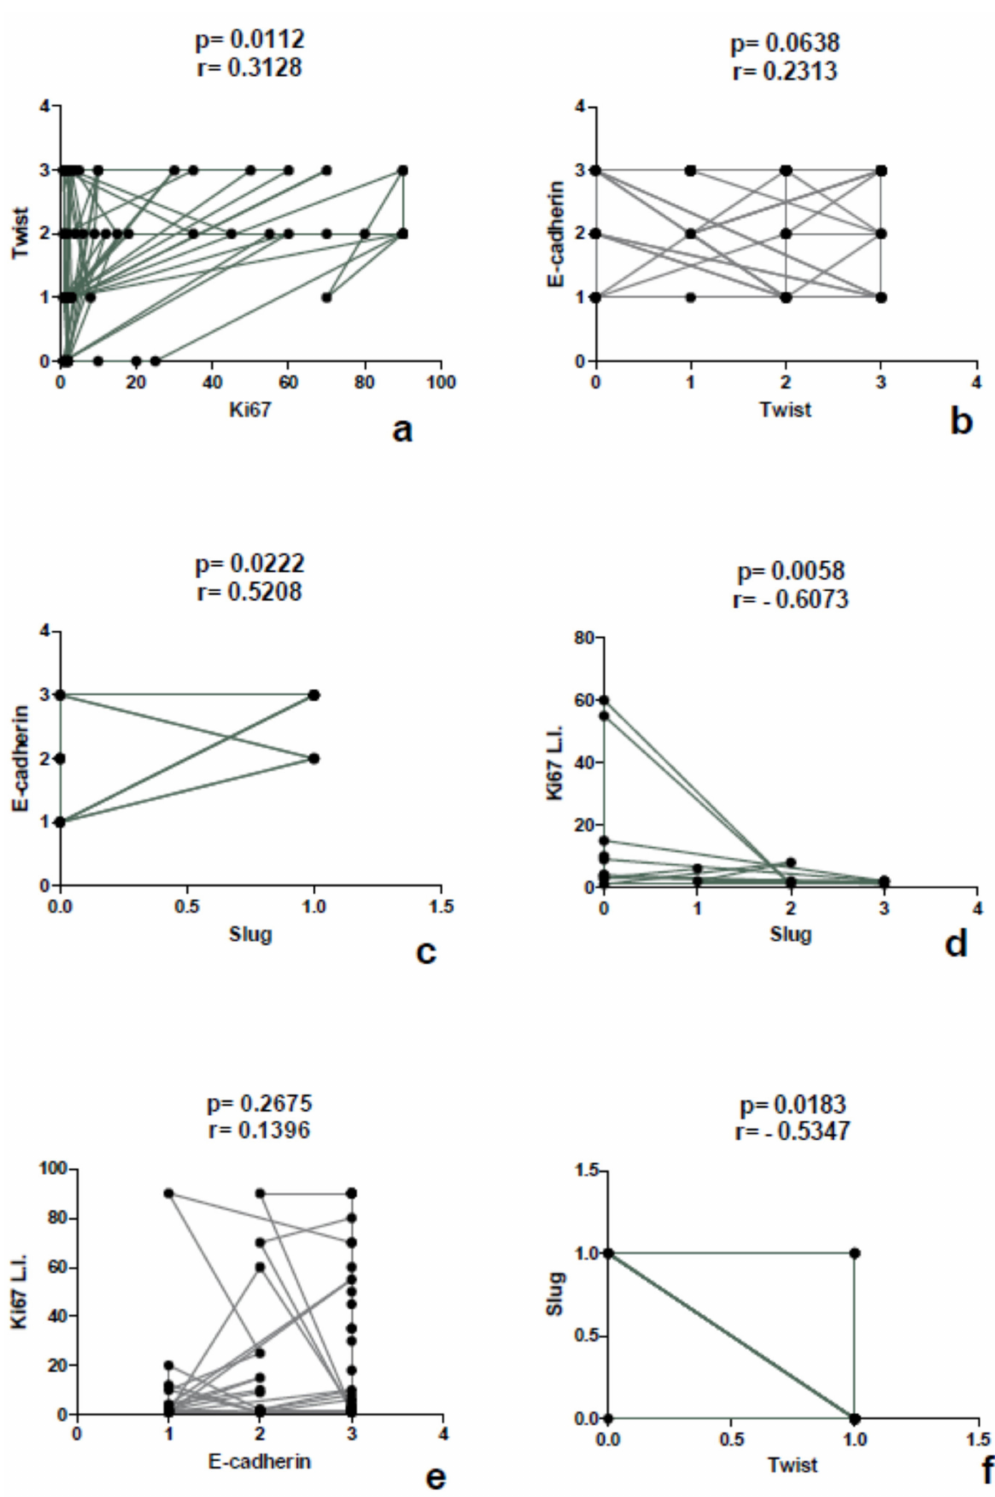
Figure 4. Correlation study between the markers performed by the Spearman’s exact test. Each dot represents a